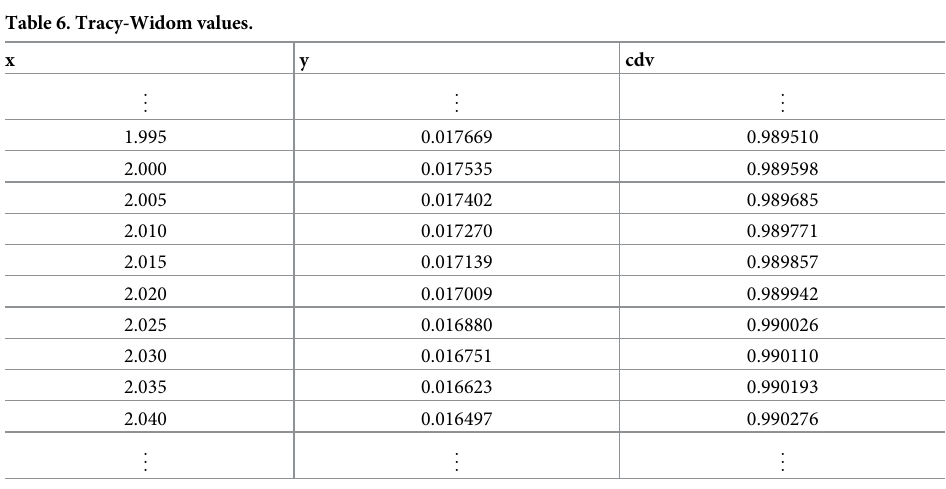
Table 6. Tracy-Widom